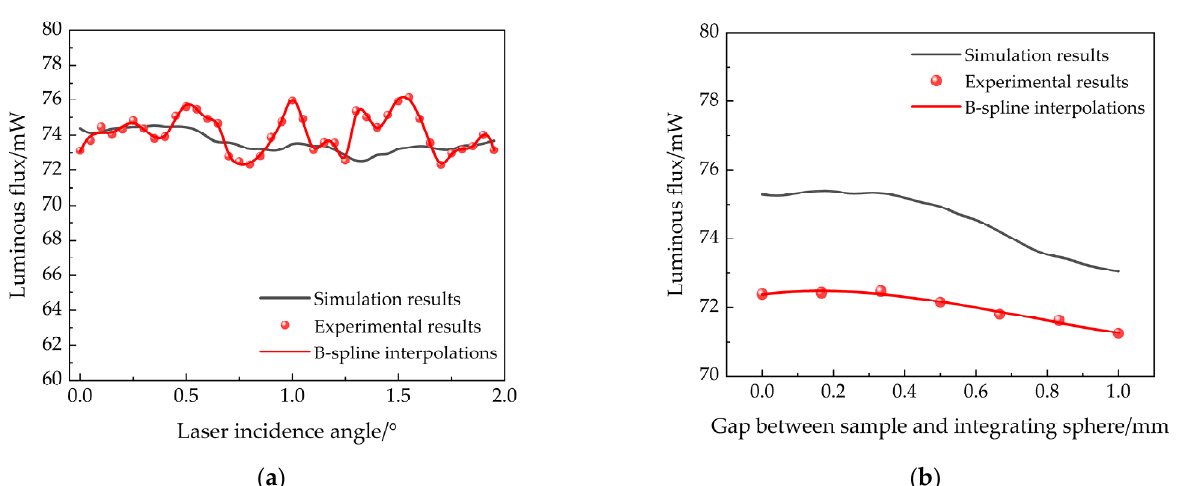
Figure 13. Influences of laser incidence angle and gap between sample and integrating sphere on measurement results: ( a ) laser incident angle and ( b ) gap between sample and integrating sphere.